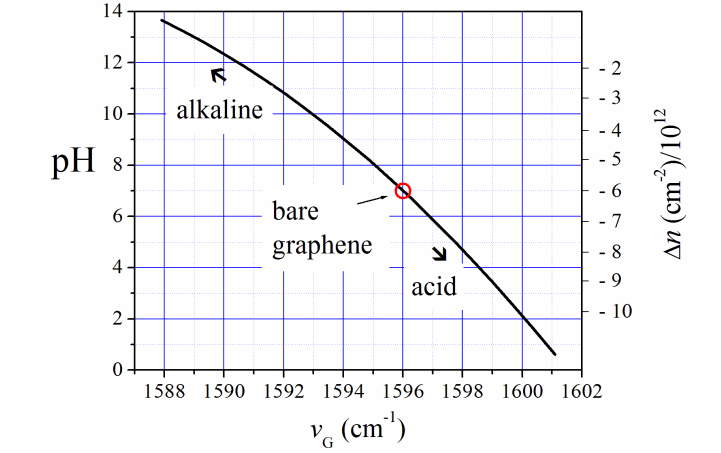
Figure 2. Expected dependence of pH and δ n excess electronic doping on the ν G energy of